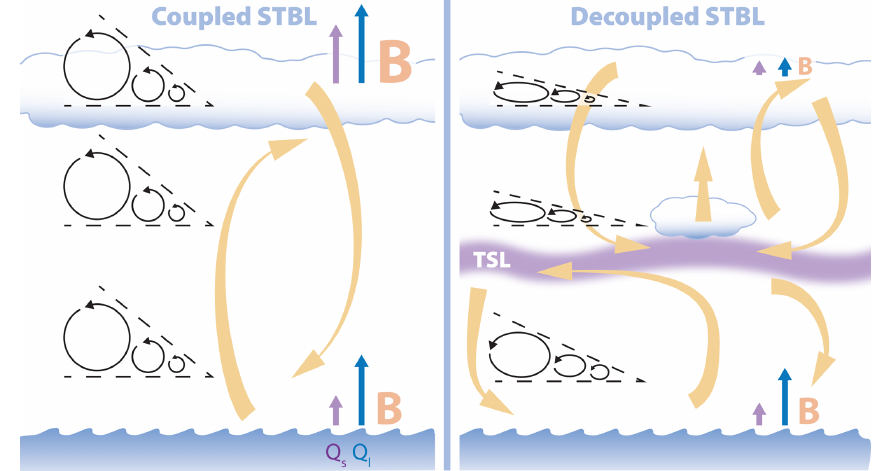
Figure 21. Schematic of main processes in the coupled (left) and decoupled (right) STBLs: primary circulation (yellow arrows), turbulence eddy cascade (circular arrows confined in an angle with extent proportional to inertial range scaling exponent p ), TKE buoyancy production (red B letter of size proportional to strength), sensible and latent heat fluxes (purple and blue arrows, respectively, of length proportional to strength) at the surface and in the cloud-top region.